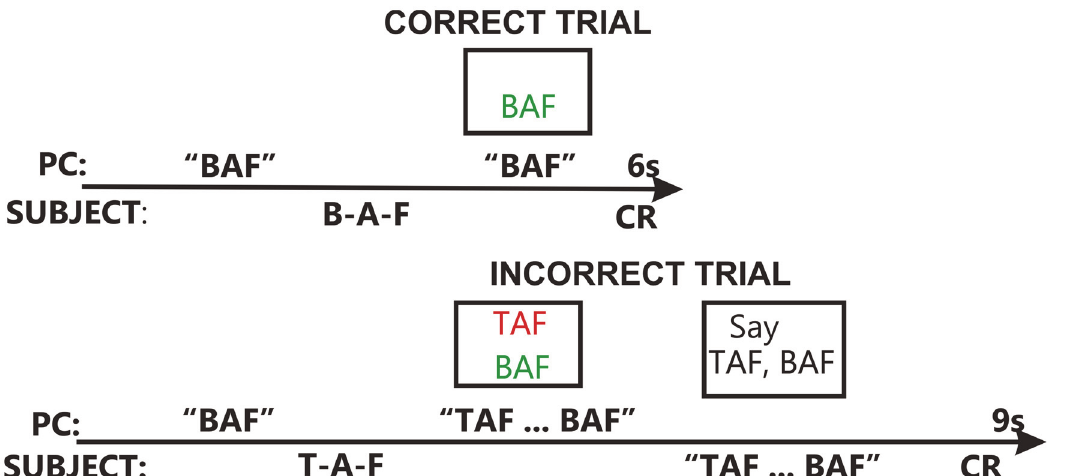
Fig 2. The structure of training trials. Top: Correct trial. After a correct response, the correctly detected token is shown in green font and the other exemplar of that token is played in quiet. Bottom: Incorrect trial. The incorrect and correct responses are shown in red and green fonts, respectively, and the two tokens are played in sequence in quiet. The listener articulates both syllables, emphasizing their phonetic